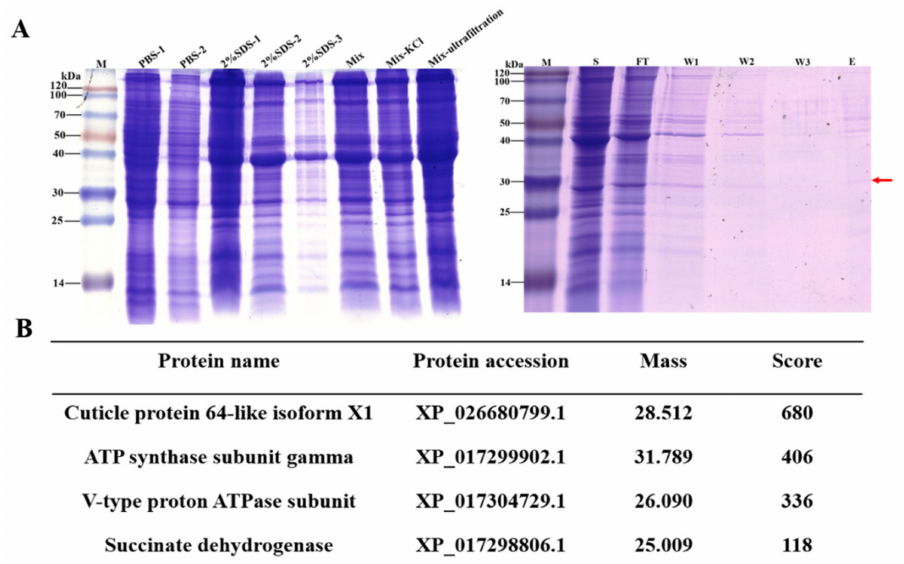
Figure 1. Extraction of D. citri cuticle protein 64 (DcCP64) by chitin-binding experiment combined with LC-MS/MS analysis. ( A ) SDS-PAGE analysis of proteins from D. citri adults, and chitin-binding assays using the mix ultrafiltration. Mix indicated the mixture of proteins isolated by PBS and 2% SDS; ( B ) Identification of DcCP64 by LC-MS/MS analysis.